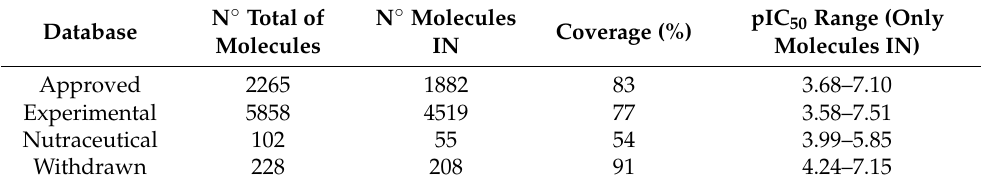
Table 2. Datasets extracted from the DrugBank 5.1.7 (https://www.drugbank.ca/ (accessed on 18 February 2021)) and used for the prospective